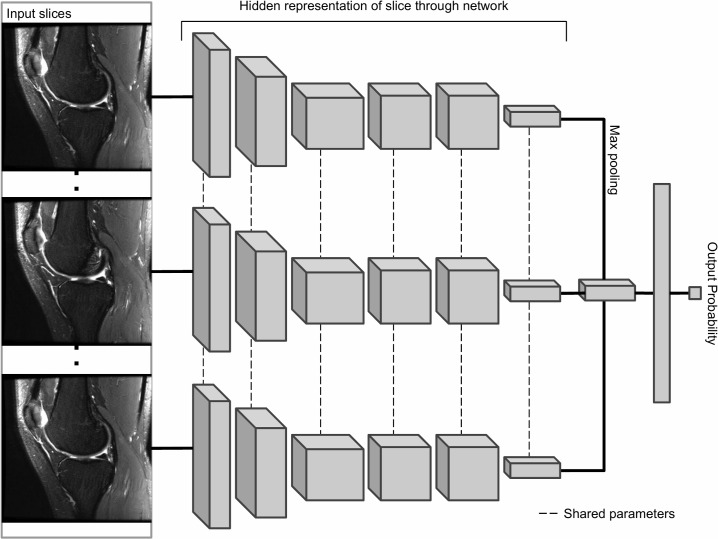
MRNet architecture.The MRNet is a convolutional neural network (CNN) that takes as input a series of MRI images and outputs a classification prediction. AlexNet features from each slice of the MRI series are combined using a max pooling (element-wise maximum) operation. The resulting vector is fed through a fully connected layer to produce a single output probability. We trained a different MRNet for each task (abnormality, anterior cruciate ligament [ACL] tear, meniscal tear) and series type (sagittal, coronal, axial), resulting in 9 different MRNets (for external validation, we use only the sagittal plane ACL tear MRNet). For each model, the output probability represents the probability that the model assigns to the series for the presence of the diagnosis.